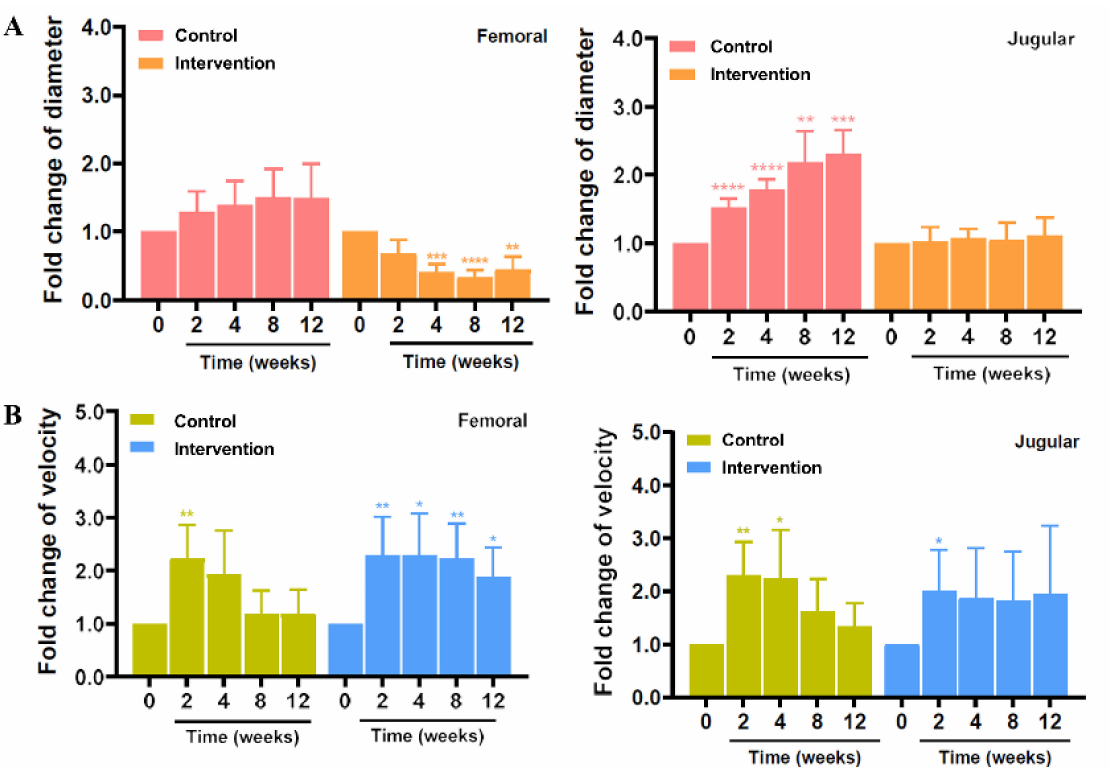
Figure 3. Mechanical effect of silk MN wrap to the vein graft. The relative fold change of ( A ) diameter and ( B ) velocity of femoral and jugular vein grafts measured by Doppler ultrasonography in the control and intervention groups (* p < 0.05; ** p < 0.01; *** p < 0.001; **** p < 0.0001).